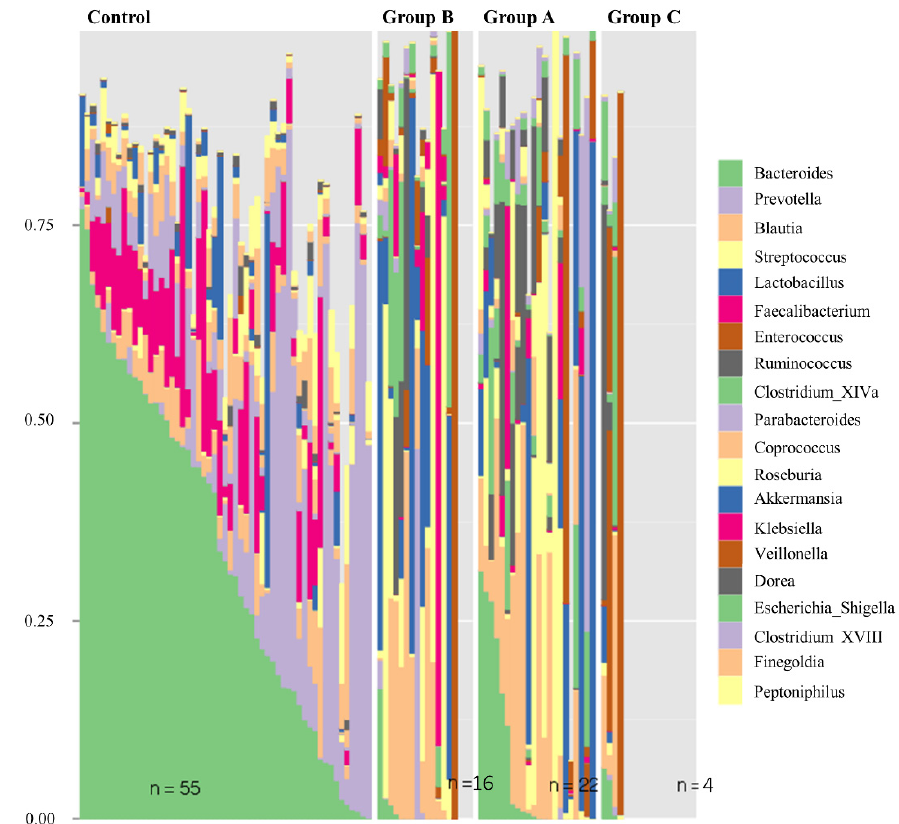
Figure 4. Relative bacterial composition based on 16S rRNA gene sequence classification at the Genus level of taxonomy by individual samples in the control group and the three transplant graft status categories. Increased similarity to the control group is seen amongst Group A than is appreciated in Group B or C.